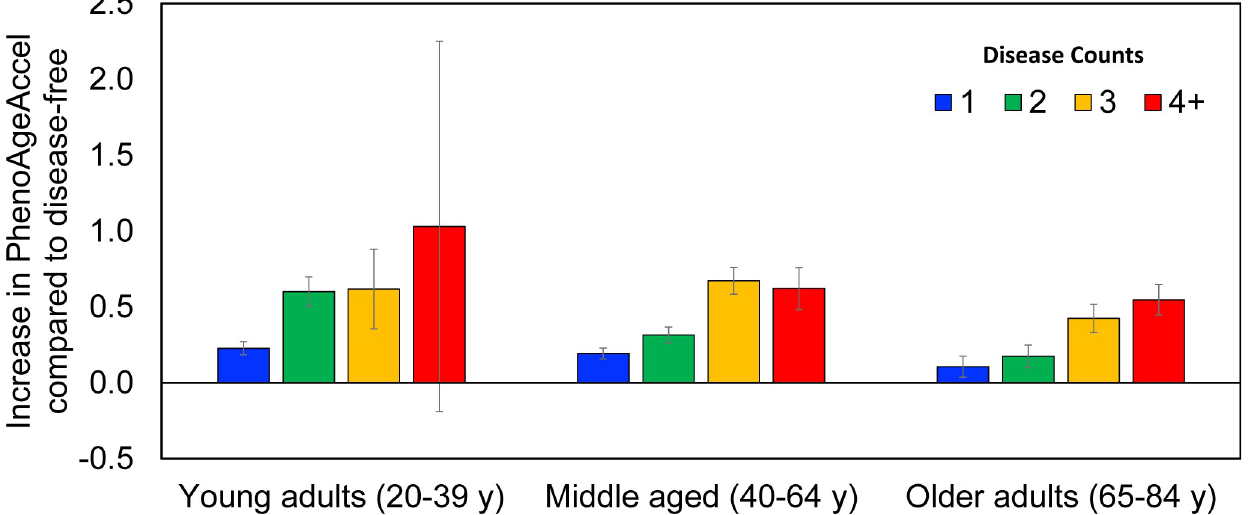
Fig 4. Predicted increase in PhenoAgeAccel for each disease count by age category. The y- axis depicts the increase in PhenoAgeAccel compared to persons who were disease-free. The x- axis shows groups categorized based on chronological age and the number of diseases each participant had. For all age categories, we observed that PhenoAgeAccel was positive among persons who were diagnosed with 1 or more chronic diseases.